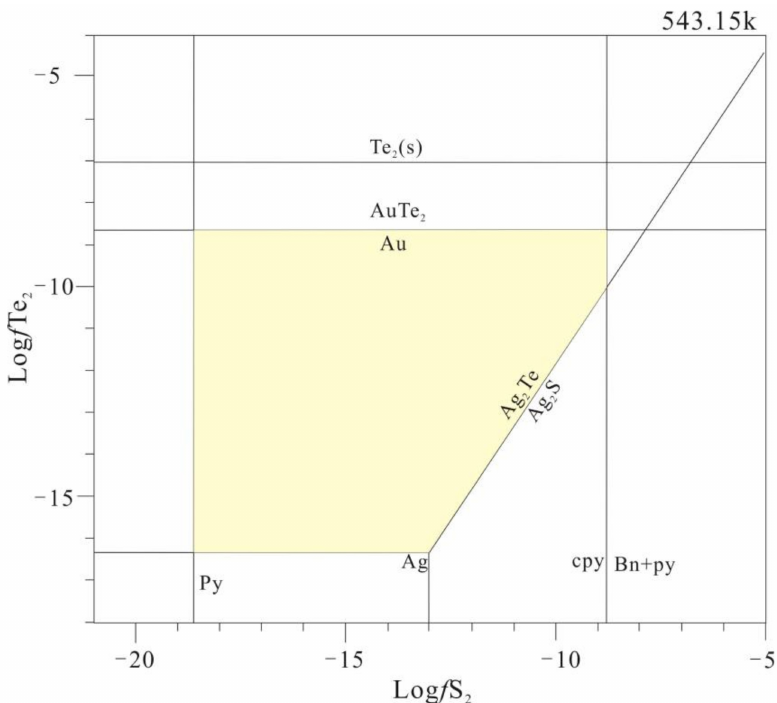
Figure 13. Log f S 2 (g)–log f Te 2 (g) diagram showing the relative stability of tellurides and sulfides at 543.15k. Because simple telluride assemblages have been recognized, the domain of variation (yellow color) is relatively